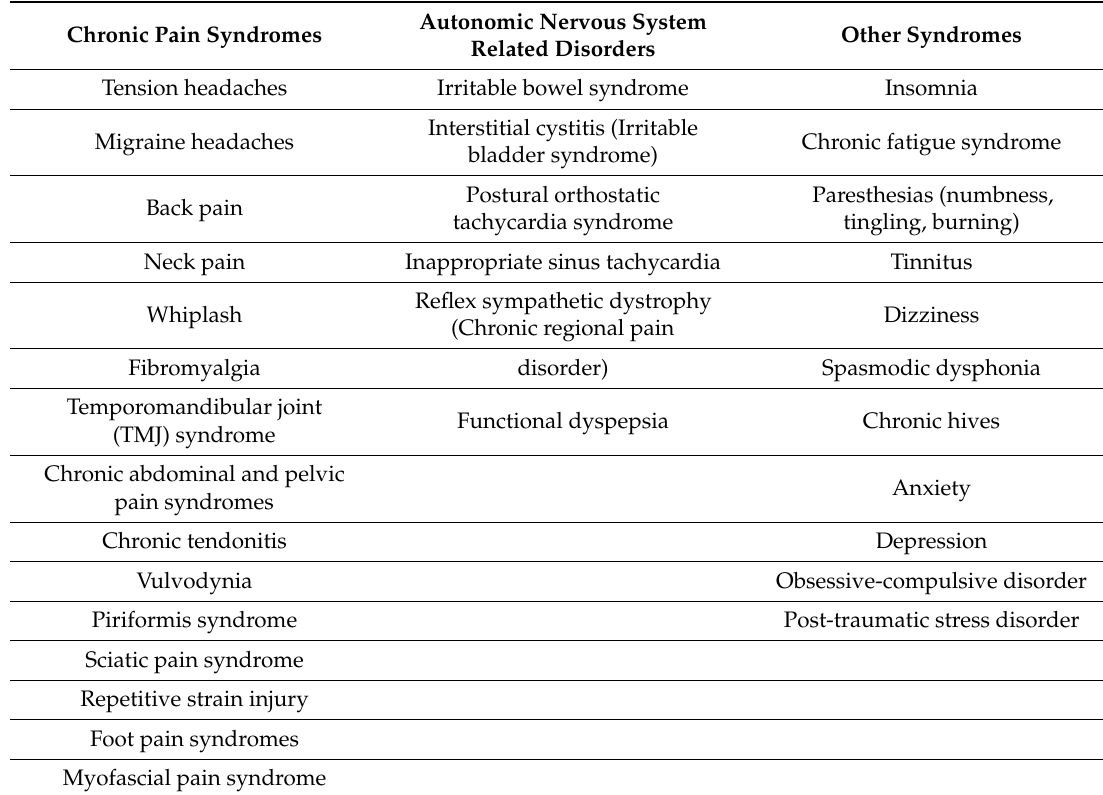
Table A3. Syndromes Commonly due to Mind–Body